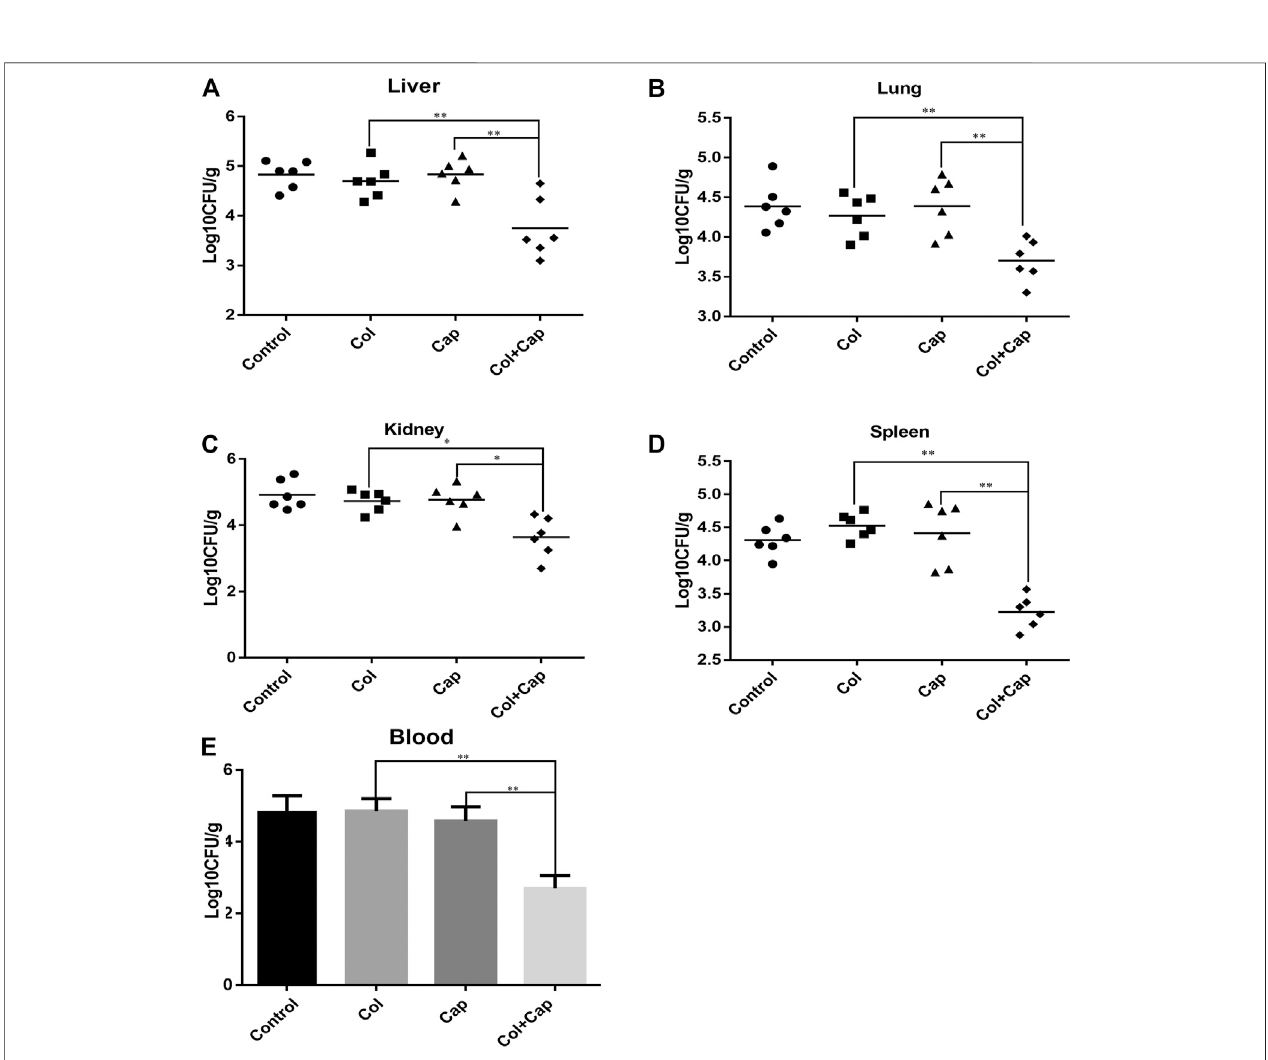
FIGURE 3 | A. baumannii burden in the target tissues [ (A) : liver, (B) : lung, (C) : kidney, (D) : spleen] were quanti fi ed as CFU per gram of target tissue in the murine bacteremiamodelfollowingdifferentregimens.E:Numberof A.baumannii containedwithintheblood.ThecontrolgroupreceivedsterilePBS,thecolistingroupreceived 5 mg/kg colistin, the capsaicin group received 3 mg/kg capsaicin, and the combination group received 5 mg/kg colistin and 3 mg/kg capsaicin. ** p < 0.01 was determined using the Student ’ s t-test. At least six mice per group were analyzed.